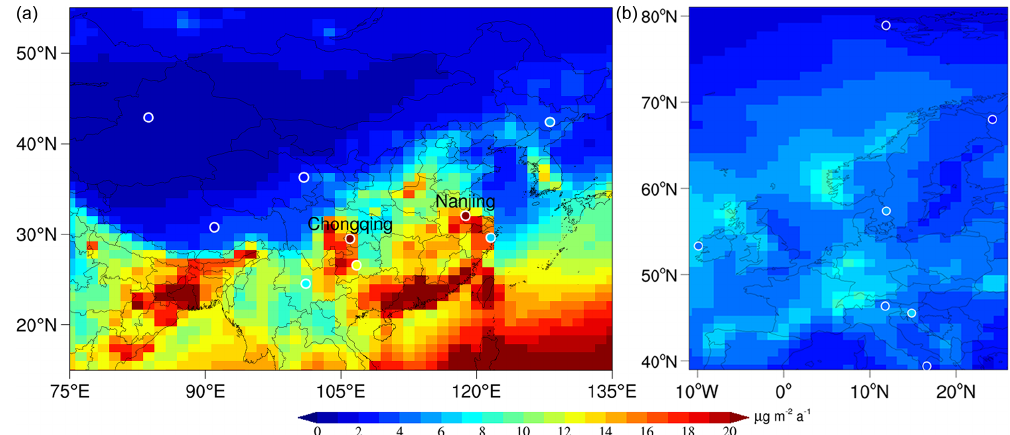
Figure 8. Same as Fig. 7, but for eastern Asia (a) and western Europe (b) . The observations (circles) are derived from recent studies by Fu et al. (2015, 2016) and Sprovieri et al. (2017), respectively. For eastern Asia, only data with > 9 months of data during 2009–2015 are included in the observations for comparison. For western Europe, the sites with sampling days greater than 60% in a year are taken as available